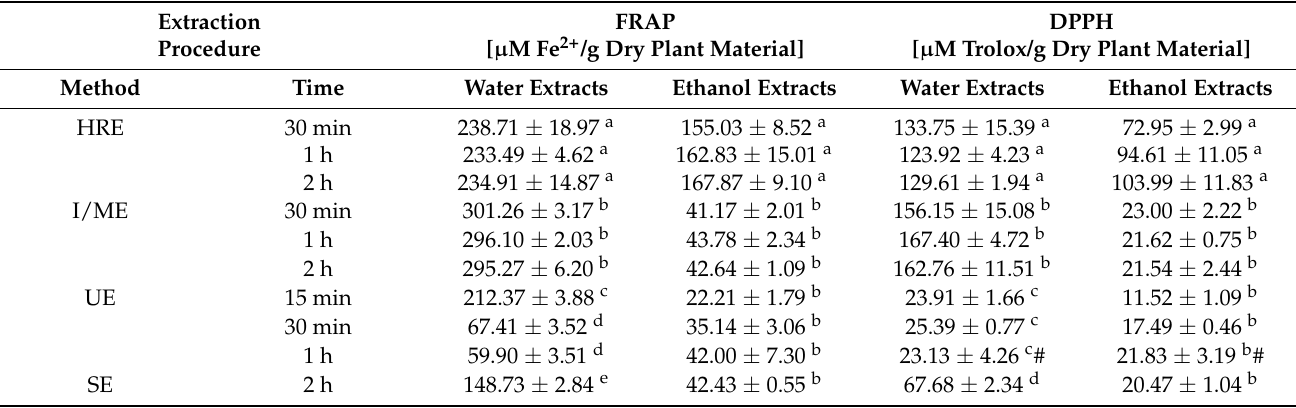
Table 3. Antioxidant activity of extracts from dried aerial parts of G. hederacea L., prepared with the use of different extraction